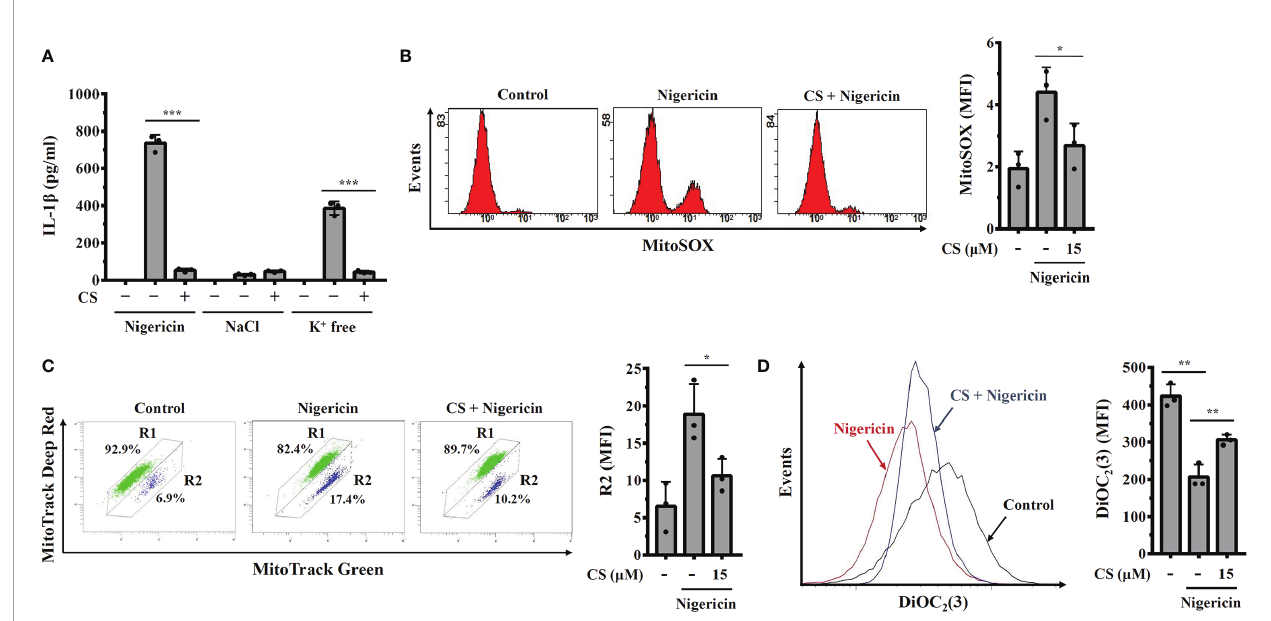
FIGURE 4 | Candesartan reduces mitochondrial dysfunction. (A) J774A.1 macrophages were primed with LPS for 5 h and incubated with CS for 0.5 h Cells were stimulated with 10 m M nigericin for 0.5 h or incubated with NaCl or K + -free medium for 2 h The levels of IL-1 b in the supernatants were measured by ELISA. (B – D) J774A.1 macrophages were primed with LPS for 5 h and incubated with CS for 0.5 h Cells were stimulated with 10 m M nigericin for 0.5 h Mitochondrial ROS were measured by MitoSOX staining (B) , mitochondrial integrity was measured by MitoTracker staining (C) , and mitochondrial membrane potential was measured by DiOC 2 (3) staining (D) . The ELISA data are expressed as the means ± SD of the three separate experiments. The mitochondrial data are representative results, and the histogram shows the quantitative results as the mean ± SD. *, ** and *** indicate a signi fi cant difference at the level of p <0.05, p <0.01 and p <0.001, respectively, as